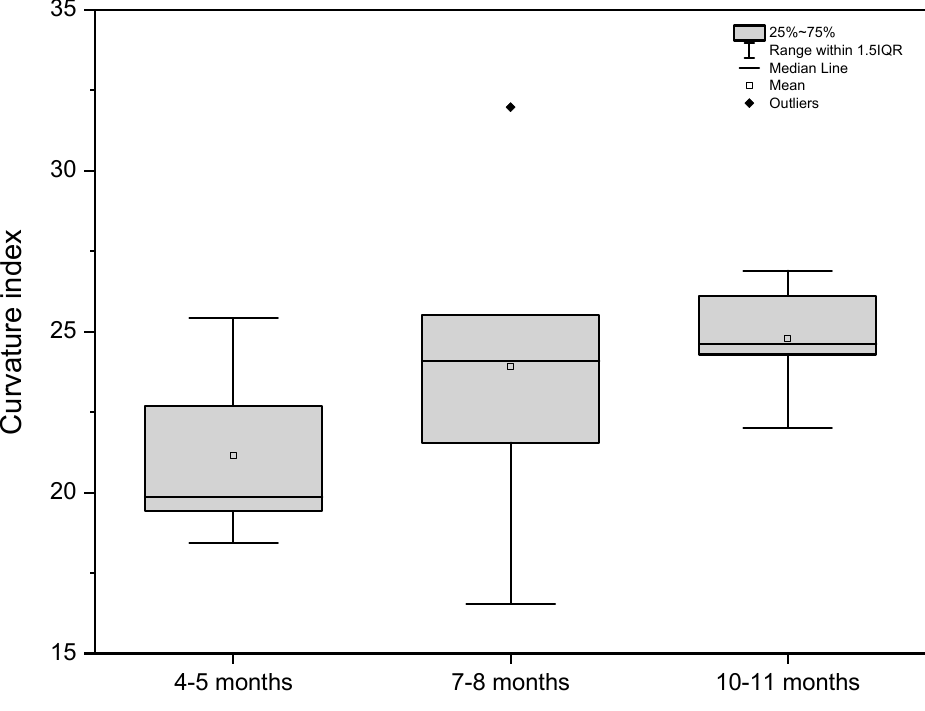
Figure 8. Curvature index values in the fetal period (4th to 11th month of gestation).